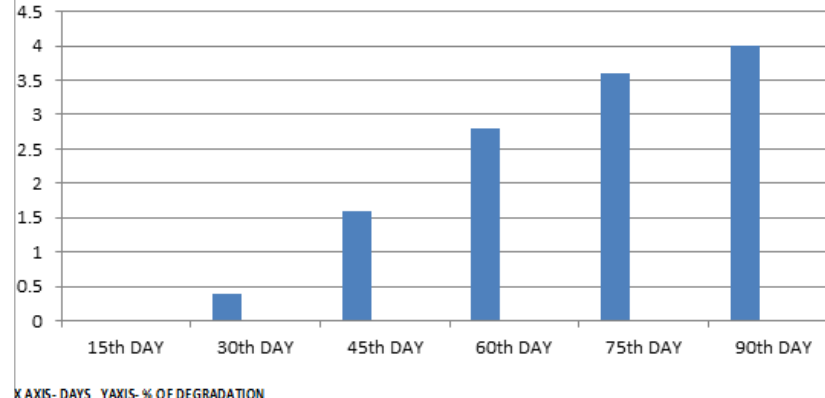
Fig. 1. Percentage of Degradation-control Land